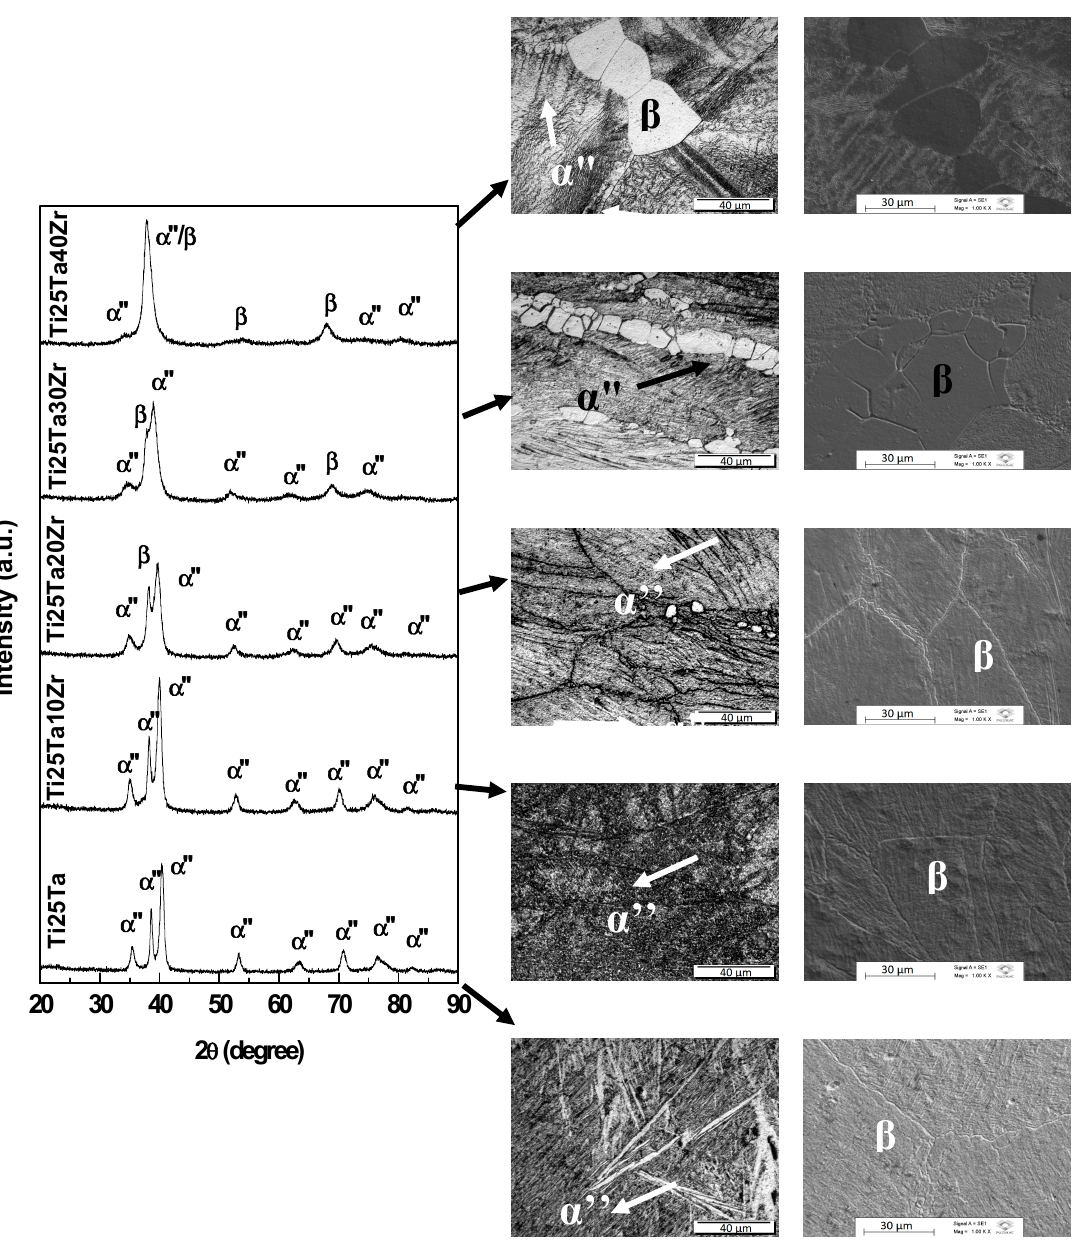
Figure 1. X-ray di ff raction patterns and optical and SEM micrographs for Ti-25Ta-xZr system alloys after hot-rolling.